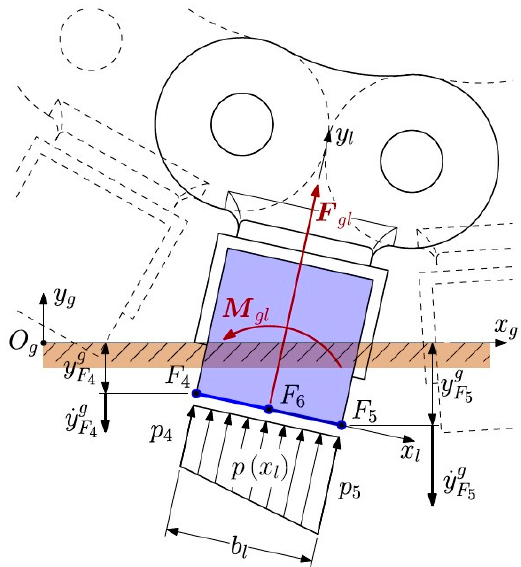
Figure 17. Illustration of the contact between rubber lugs and the